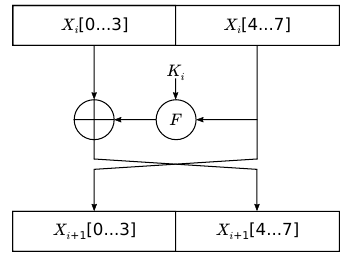
Figure 1: Example of a conventional (Bal- anced) Feistel construction, where i is the round